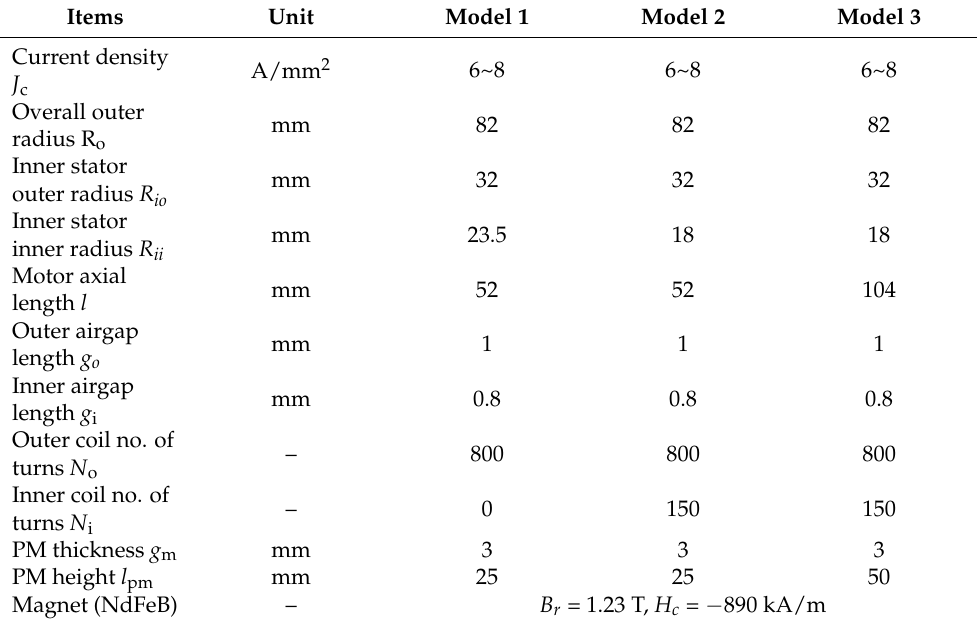
Table 1. Design parameters of electromagnetic parts in three